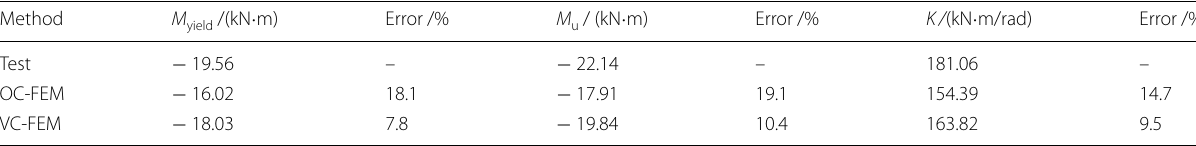
M yield is the yielding moment of the negative loading cycles, and is calculated by the equivalent energy elasto-plastic (EEEP) method [8, 46, 47]; M u represents ultimate moment of the negative loading cycles; K stands for the bending stiffness, which is equal to the ratio of ultimate moment to ultimate rotation angle